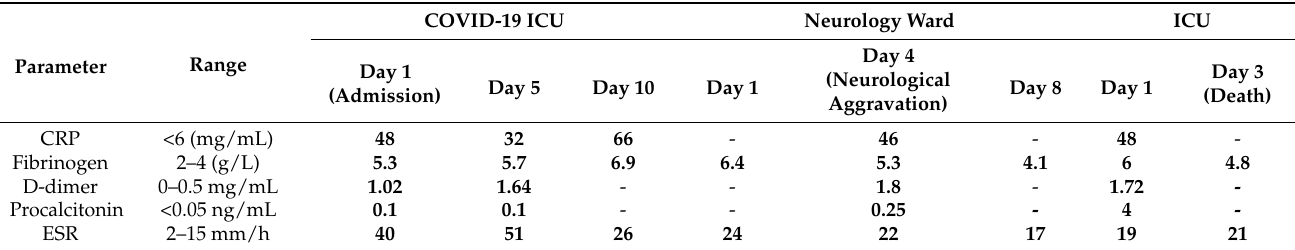
Table 2. Evolution of inflammatory markers.